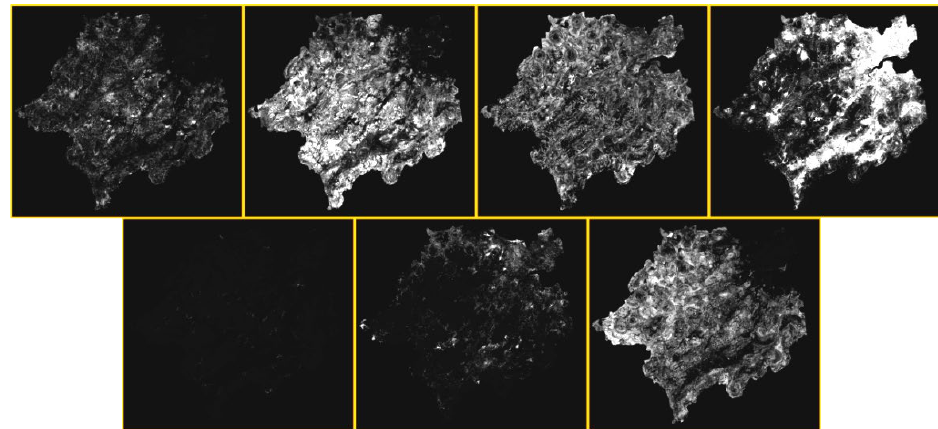
Figure 7. Development probabilities for various types of land, and the contribution of land expansion in 2005–2010 (the clearer the white, the greater the contribution).